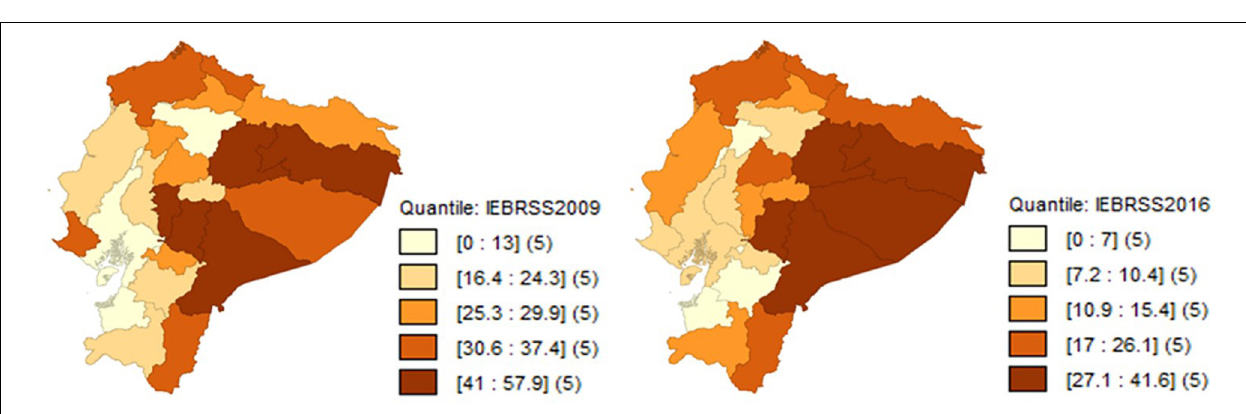
Domingo de los Tsáchilas, which decreased from 48.2%